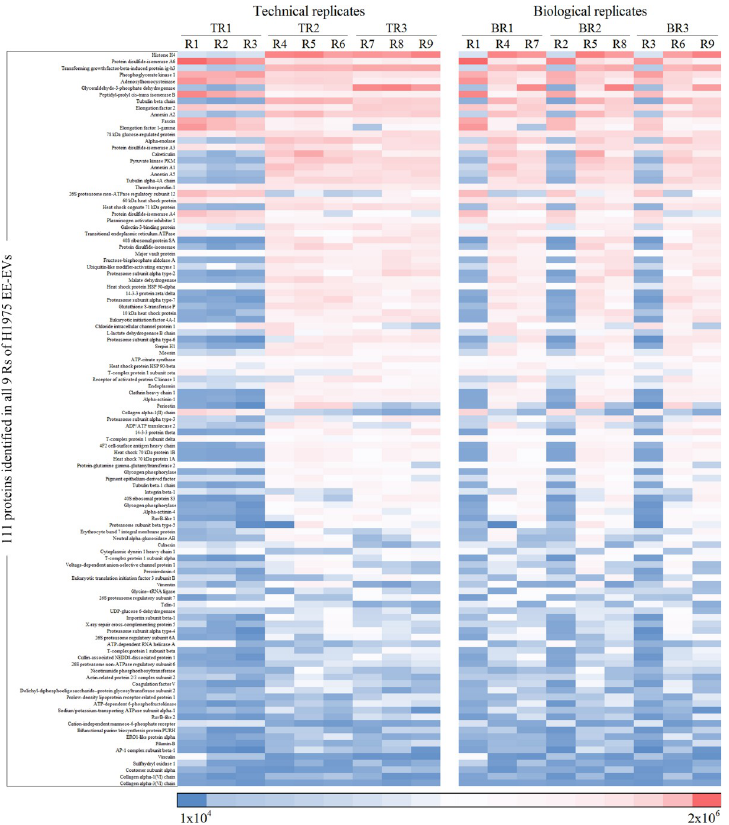
Fig 9. Heatmap representing exosomal proteins identified in H1975 in order of decreasing levels in TRs (R1-R2-R3, R4-R5-R6, R7-R8-R9) and in BRs (R1-R4-R7, R2-R5-R6, R3-R6-R9). Boxes highlighted in dark red represent the most abundant, while boxes in dark blue represent the least abundant